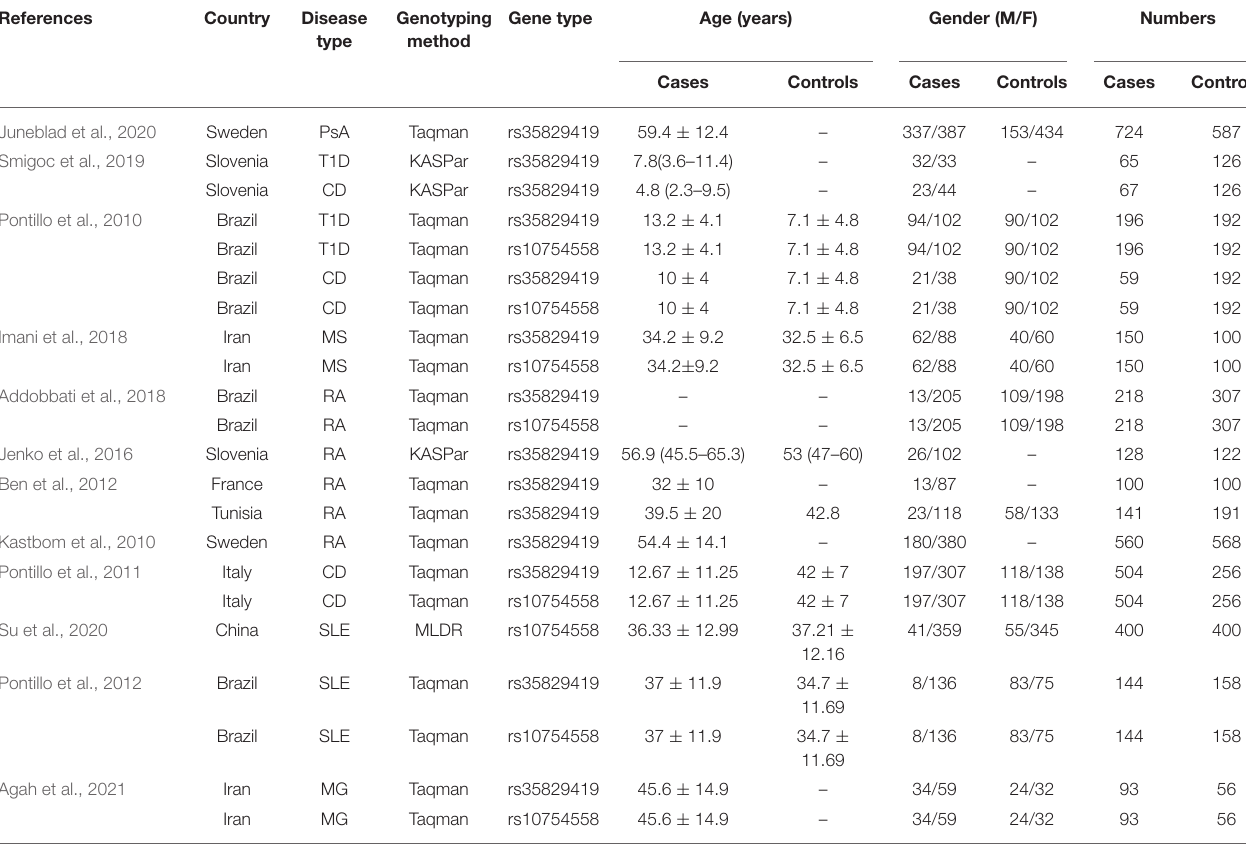
TABLE 1 | Baseline characteristics of eligible studies in all included